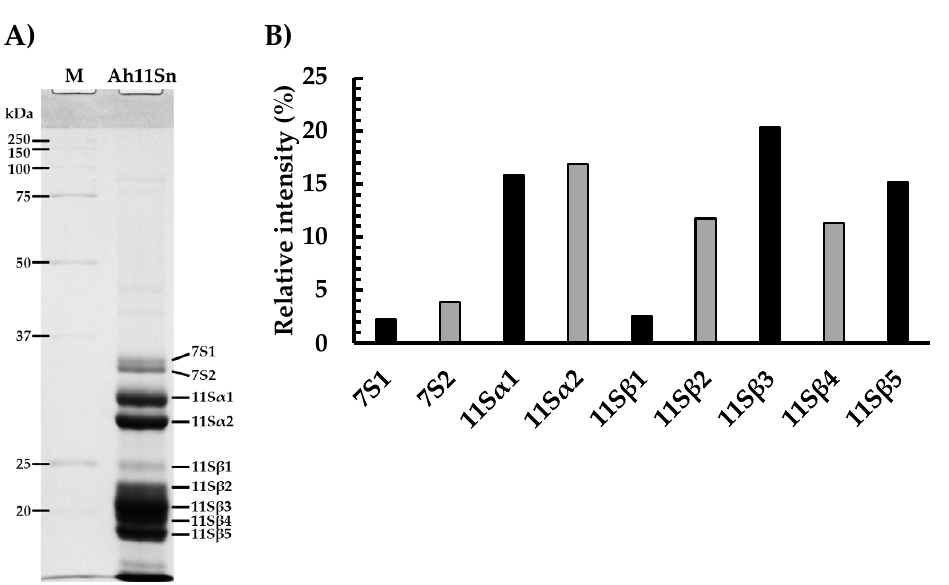
Figure 1. ( A ) Electrophoretic profile of Ah11Sn under reducing conditions. ( B ) Densitometry anal-